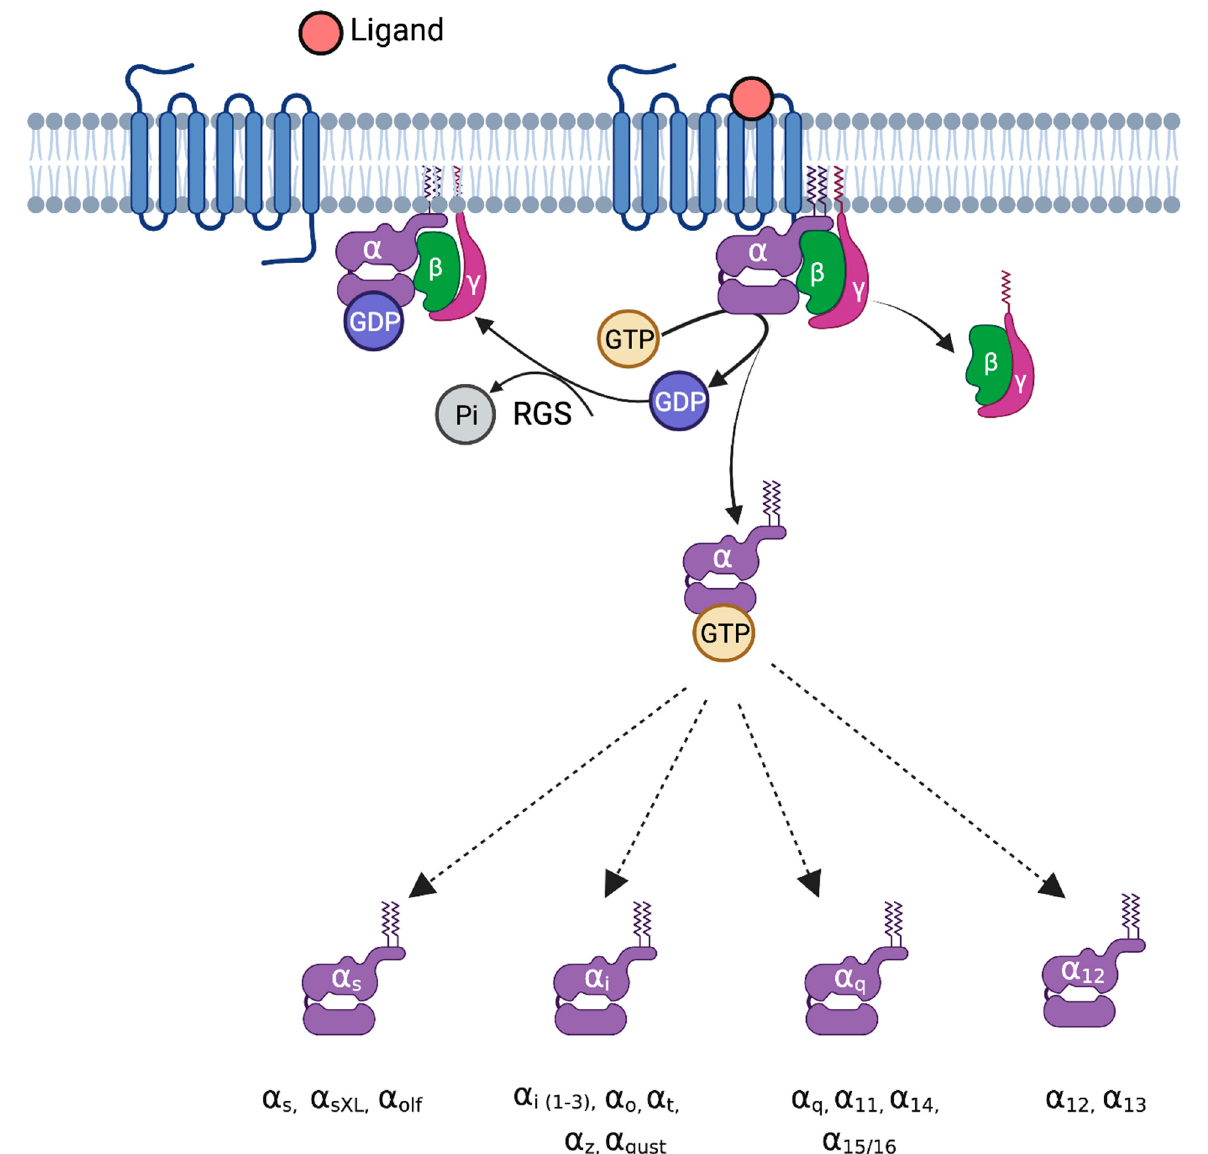
Figure 1. G-proteins and their mechanism of activation. Upon ligand binding to G-protein-coupled receptors, the exchange of GDP for GTP takes place on the G α subunit, leading to decreased binding affinity for G βγ . The GTP-bound G α interacts with several downstream effectors and leads to various pathophysiological functions. Based on sequence homology and activity, G α proteins are classified into four groups: G-alpha-s (stimulatory), G α i (inhibitory), G α q, and G α 12/13. G α s is divided into G α s, G α XL (extra-long), and G α olf (olfactory). The G-alpha-i family is divided into G α i (1-3), G α